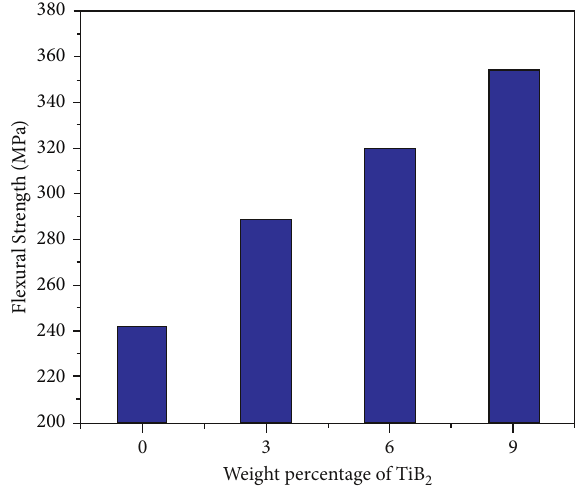
Figure 9: Influence of flexural strength on the wt% of TiB